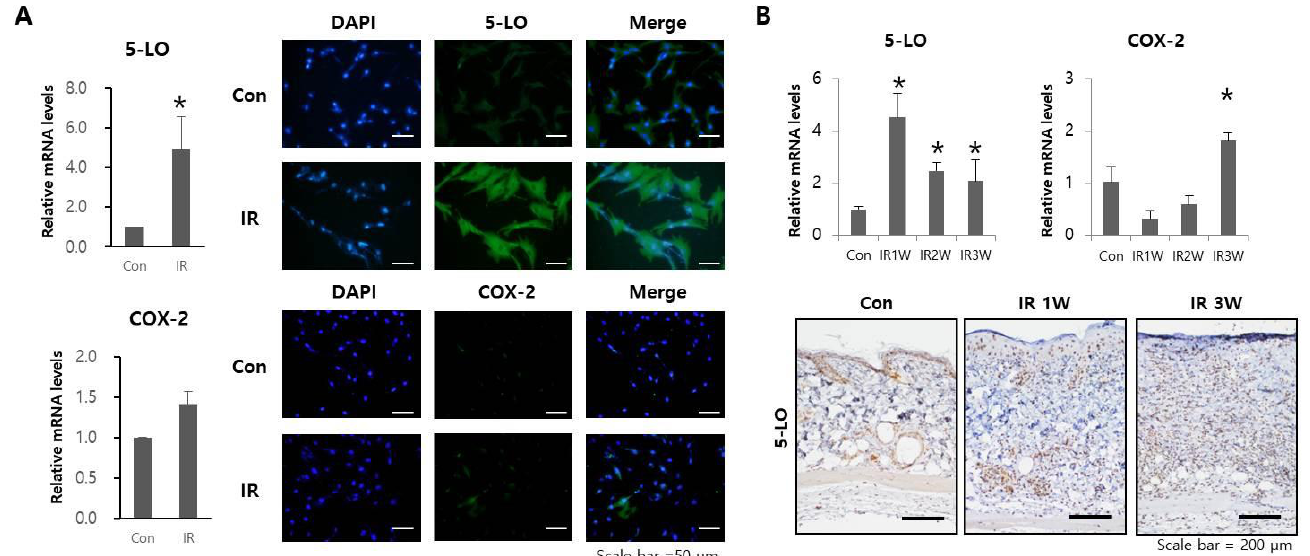
Figure 2. Expression of 5-LO and COX-2 in HDFs and mouse skin tissue after radiation exposure. ( A ) mRNA expression levels and representative immunostaining images of 5-LO ( top ) and COX-2 ( bottom ) in HDFs after radiation exposure. Data are presented as mean ± standard deviation, with statistical significance set at * p < 0.05 vs. control group (Con). ( B ) mRNA expression levels of 5-LO and COX-2 ( top ), as well as representative immunostaining images of 5-LO ( bottom ) in mouse skin after radiation exposure. Data are presented as mean ± standard error, with statistical significance set at * p < 0.05 vs. control group (Con). Six mice per group were used.